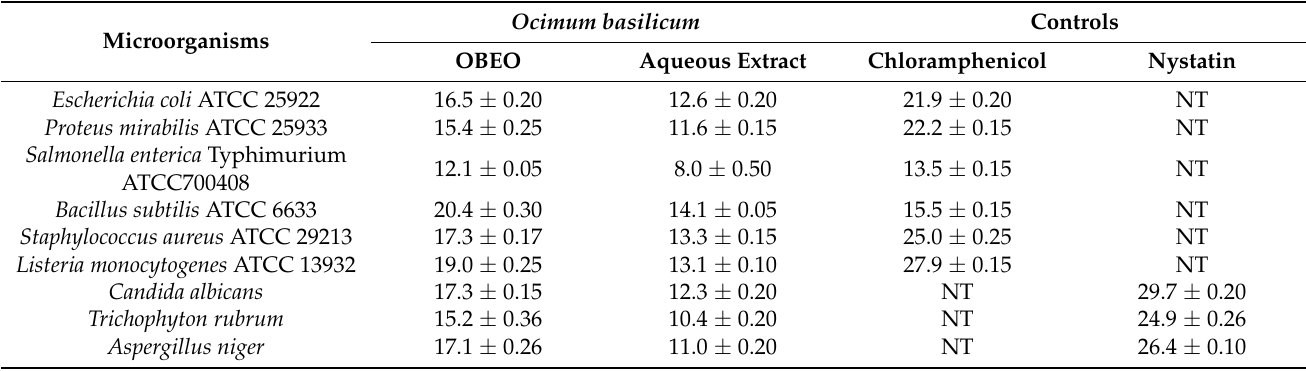
Table 3. Diameters of the inhibition zones (mm) of O. basilicum EO and aqueous